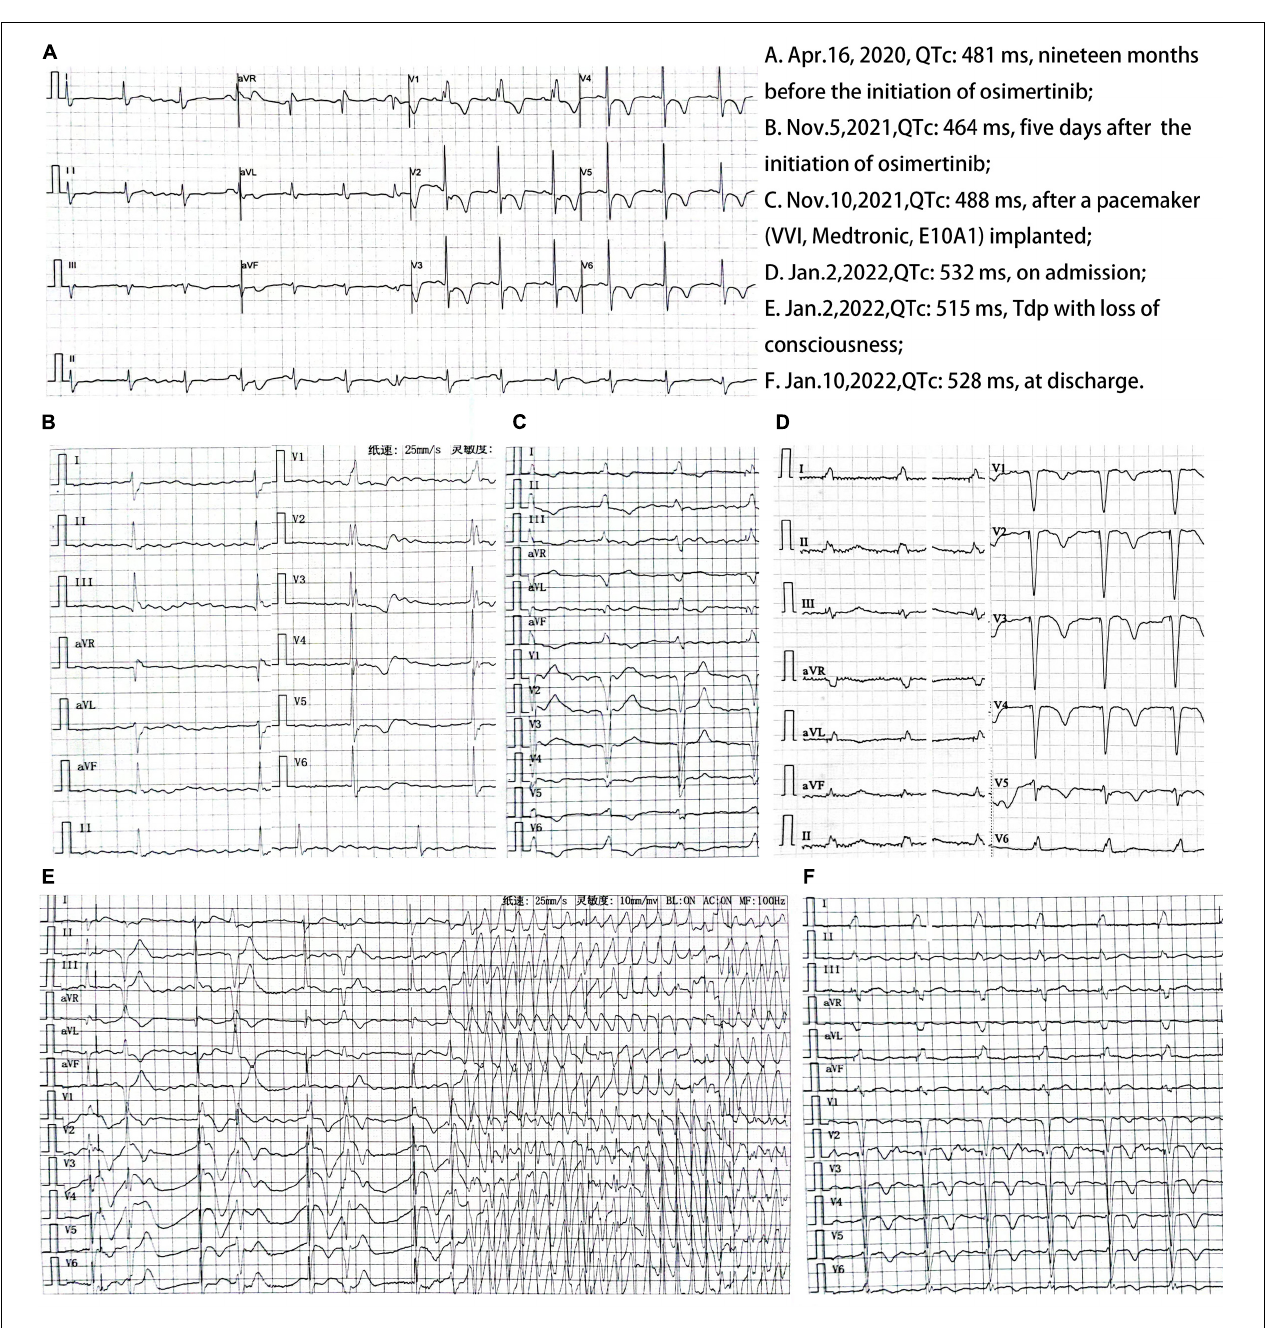
FIGURE 1 | Twelve-lead electrocardiogram